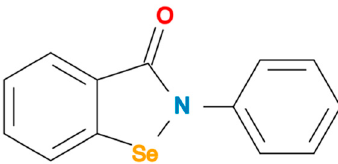
Figure 1. Chemical structure of ebselen. Abbreviation: O: oxygen; N: nitrogen; Se: selenium.